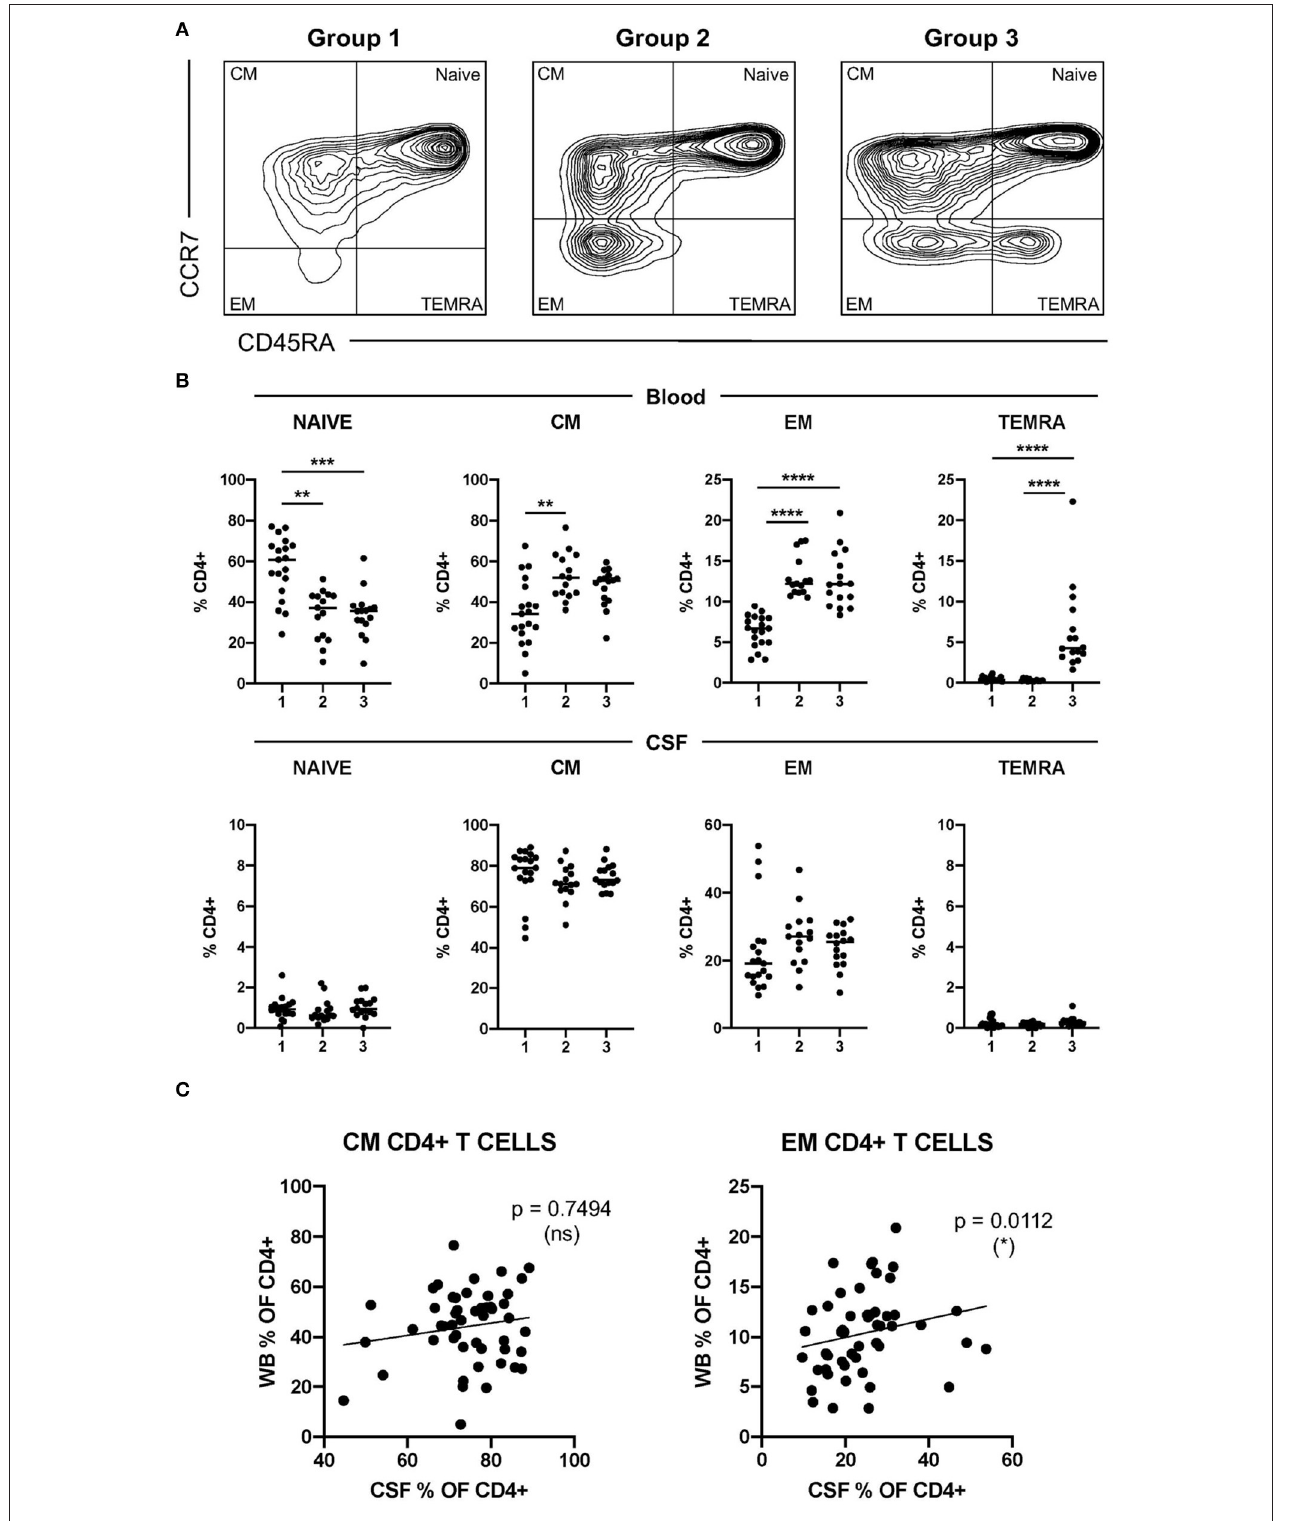
FIGURE 1 | Characterization of CD4 + T-cell senescence using the maturation stage. (A) Dot plot showing CCR7 and CD45RA expression on peripheral circulating CD4 + T cells from patients with multiple sclerosis (MS) with low (group 1, left plot), intermediate (group 2, middle plot), and high (group 3, right plot) levels of CD4